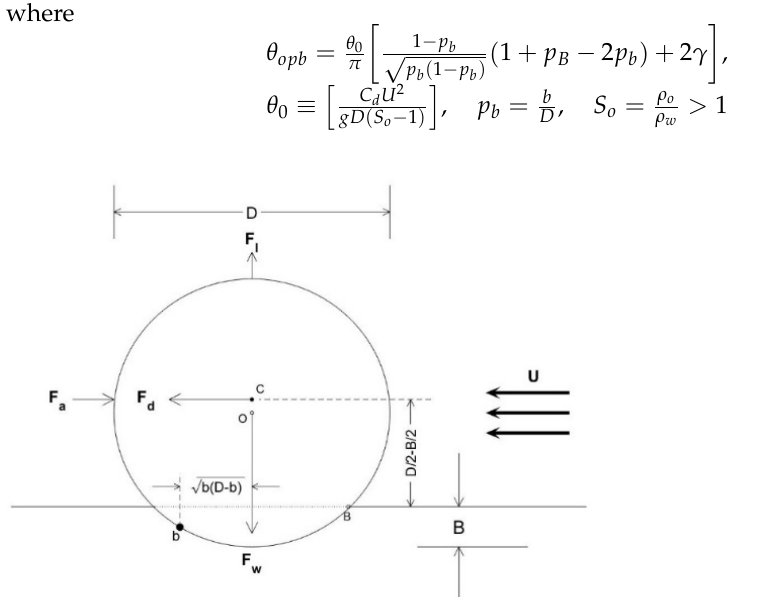
Figure A2. Forces and torques due to drag, lift, buoyancy, and added mass on a partially buried cylinder by combination of ocean currents and bottom wave orbital velocity ( U ) perpendicular to the major axis of the cylinder.